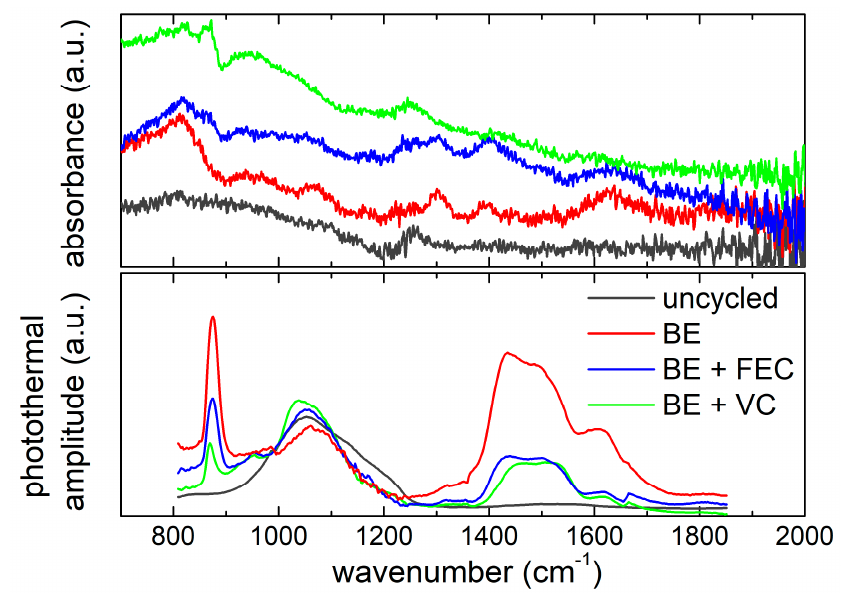
Figure 7. Comparison between ATR-FTIR spectra (top panel) and O-PTIR spectra (bottom panel) of the Si NW electrodes, before and after cycling in the three electrolytes. O-PTIR spectra are normalized at photothermal amplitude of Si–C stretching vibration (990 cm − 1 ).